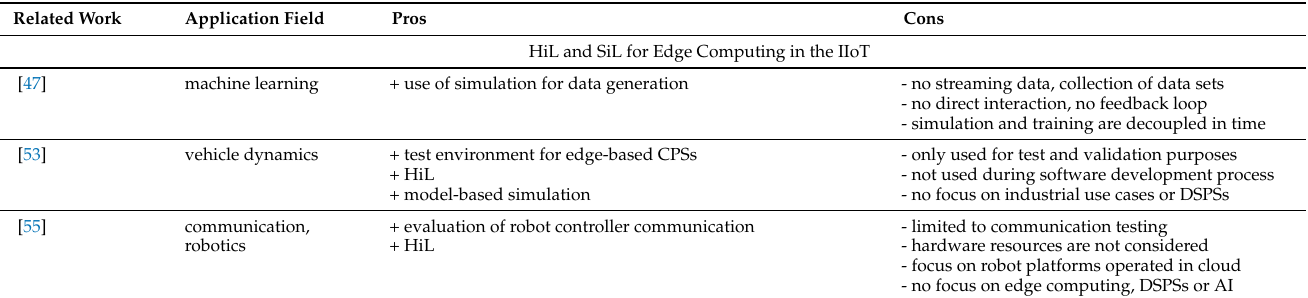
Table 2. Summary of pros and cons of related